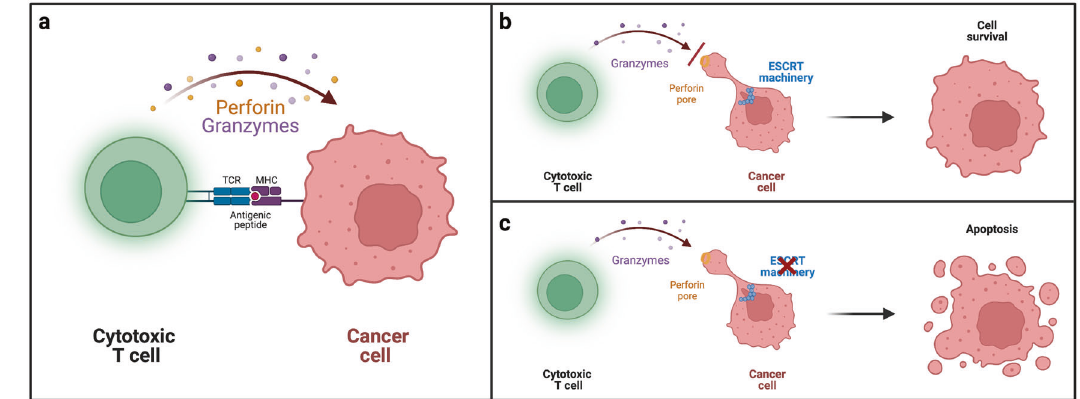
Fig. 1 a Schematic illustration of secretion of the pore-forming toxin perforin and the following delivery of apoptosis-inducing serine proteases (granzymes). b Membrane repair of perforin pores by the ESCRT machinery limits granzyme entry into the cytosol, allowing target cells to better resist the cytolytic attack. c Inhibition of the ESCRT machinery in cancer cells increases their susceptibility to cytotoxic T cell- mediated